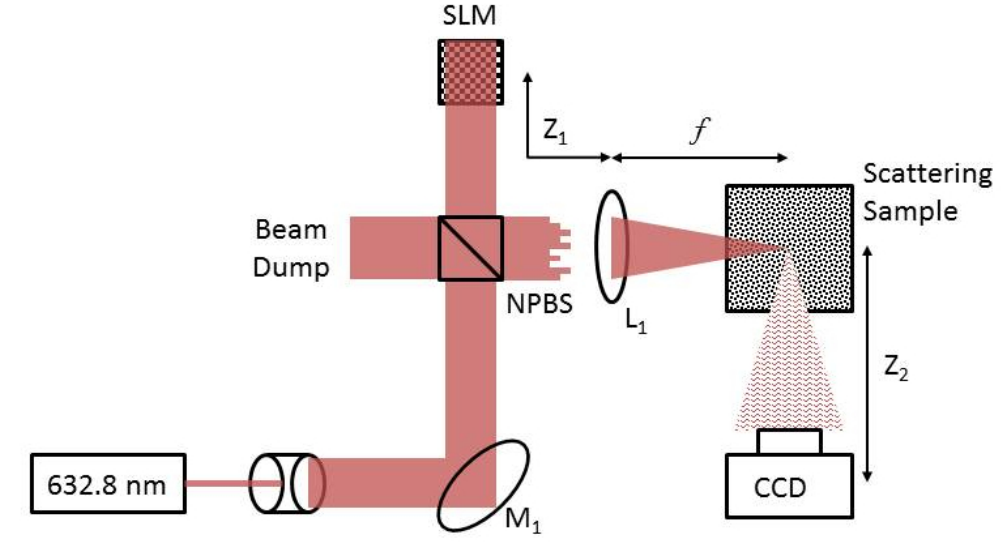
Figure 1. Focal-plane optical setup for reflective inverse diffusion. A vertically polarized HeNe laser is expanded, collimated, and normally incident on the SLM (spatial light modulator). The phase modulated beam is then focused onto the rough-surface reflector with positive lens ( L 1 ) and the reflected speckle pattern is recorded by the CCD (charged-coupled device). The mirror ( M 1 ) and the NPBS (non-polarizing beam splitter) are used to allow normal incidence with the SLM. For focal-plane experiments and simulations, the lens focal length, f , is 500 mm, and the distances Z 1 and Z 2 are 15 ± 0.5 cm and 50 ± 0.5 cm,